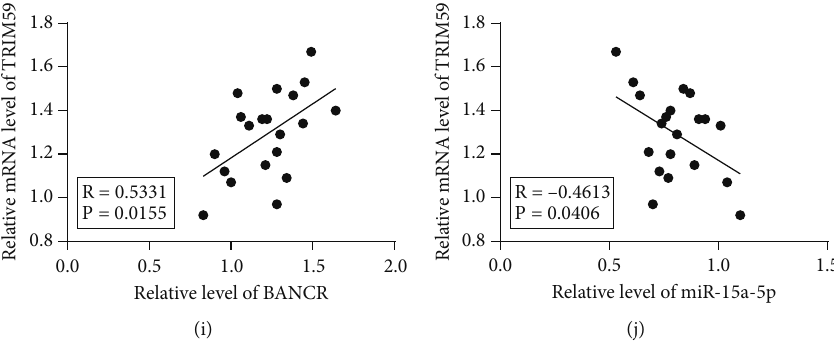
Figure 4: miR-15a-5p targets and inhibits TRIM59. (a) Downstream target genes of miR-15a-5p were predicted on the Starbase and miRWalk databases and intersections were identi fi ed; (b) Bindings sites of miR-15a-5p to TRIM59 were predicted on the Starbase database; (c) Binding relationship between miR-15a-5p and TRIM59 in Ect-ESCs was testi fi ed by the dual-luciferase assay; (d) Levels of TRIM59 in eutopic and ectopic endometrial tissues ( N = 20 ) were determined by RT-qPCR; (e) – (f) Expression levels of TRIM59 in Eut- ESCs and Ect-ESCs were determined by RT-qPCR (e) and Western blot assay (f); (g) – (h) Expression levels of TRIM59 in Ect-ESCs were determined by RT-qPCR (g) and Western blot assay (h); (i) Correlation between lncRNA BANCR and TRIM59 in ectopic endometrial tissues of EM patients ( N = 20 ) was analyzed by Pearson correlation analysis; (j) Correlation between miR-15a-5p and TRIM59 in ectopic endometrial tissues of EM patients ( N = 20 ) was analyzed by Pearson correlation analysis. Cell experiments were performed thrice independently. Data in fi gures (c), (e), and (h) were formalized as mean ± SD. Data in fi gure (c) were analyzed using two-way ANOVA, data in fi gures (d) – (f) were analyzed using the t test, and data in fi gures (g) – (h) were analyzed using one-way ANOVA, followed by Tukey ’ s multiple comparison test. ** P < 0 : 01